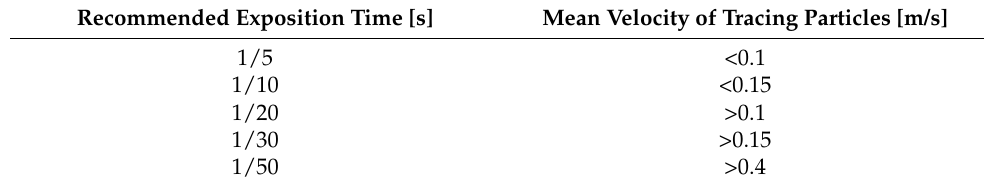
Table 2. Recommended exposition times depending on the liquid velocities [21].